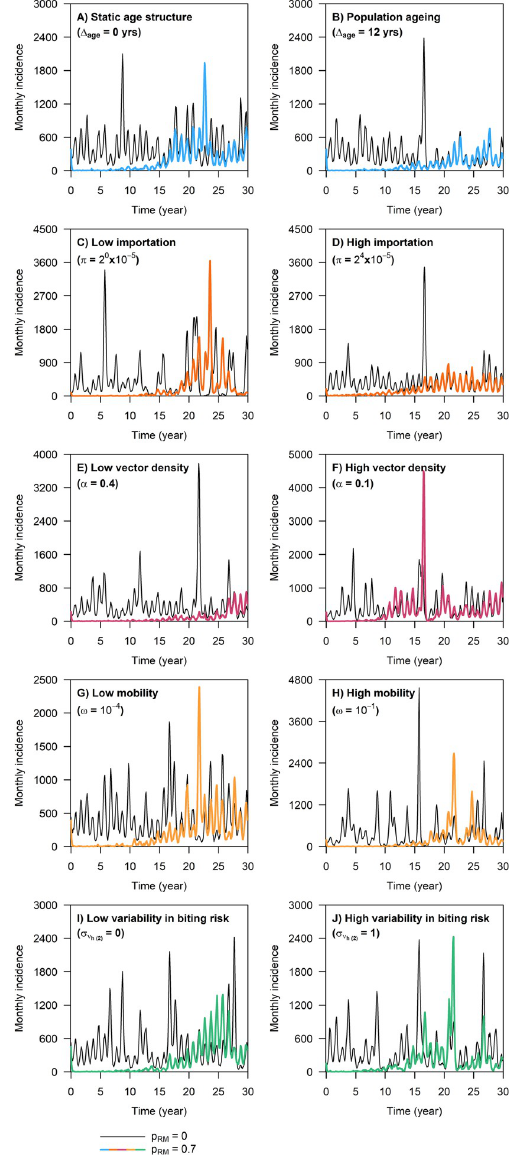
Fig 3. Simulated monthly number of dengue infections during the 30-year intervention period in different dengue endemic settings. Each figure panel showed model outputs obtained from two simulation runs with the same starting condition, where one simulation was performed without vector control and the other with the vector population size permanently reduced by 70% at the start of the intervention period (identical to the corresponding model output shown in Fig